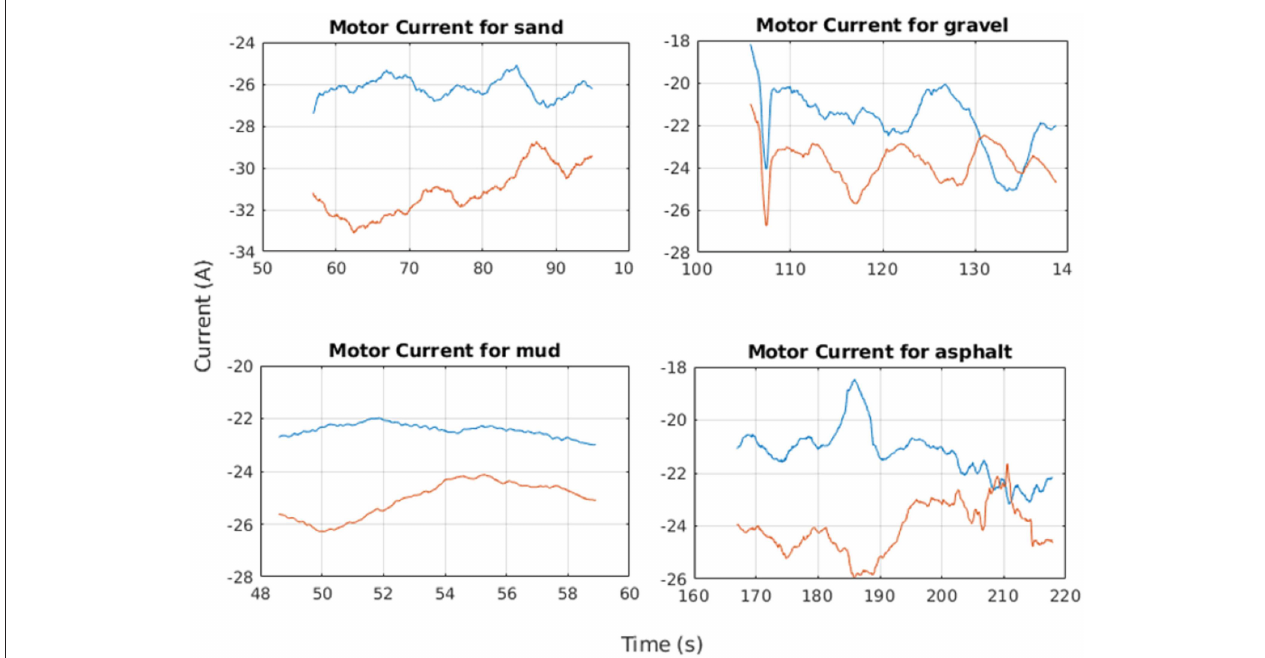
FIGURE 11 | Motor current values for sand, gravel, mud, and asphalt.